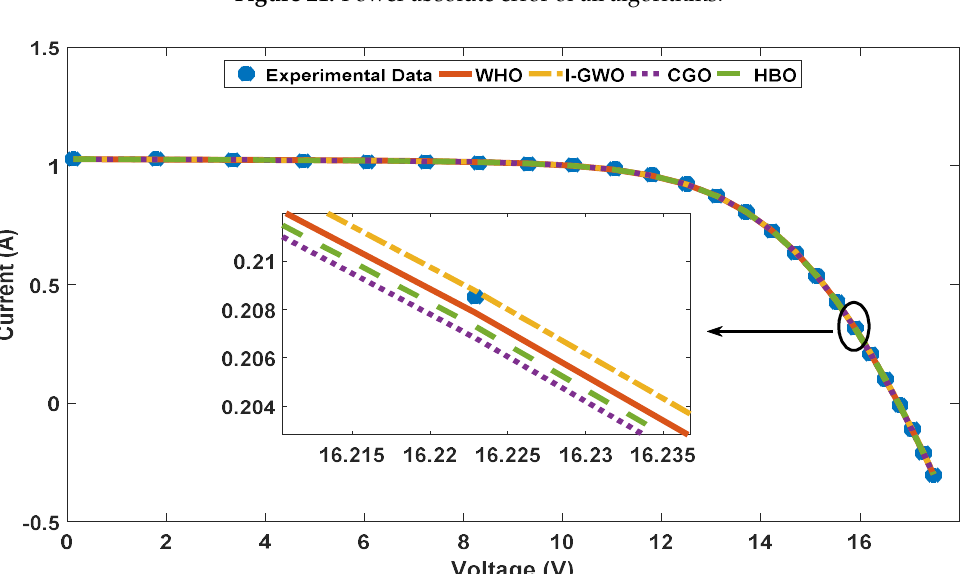
Figure 22. Current–voltage characteristic curve comparison between real data and all estimated TDM by different algorithms.